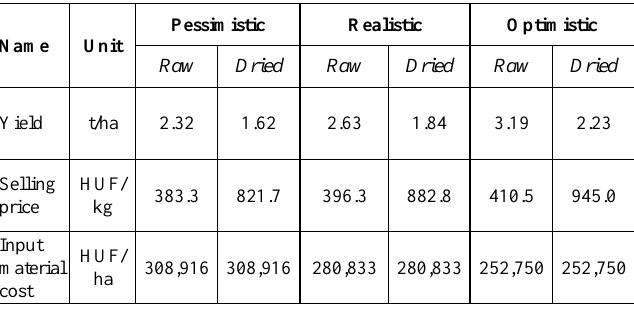
Table 7. Values of main factors affecting profit in different scenarios